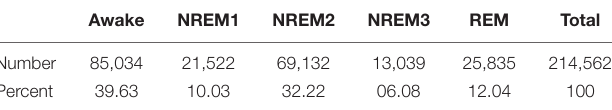
TABLE 1 | Distribution of